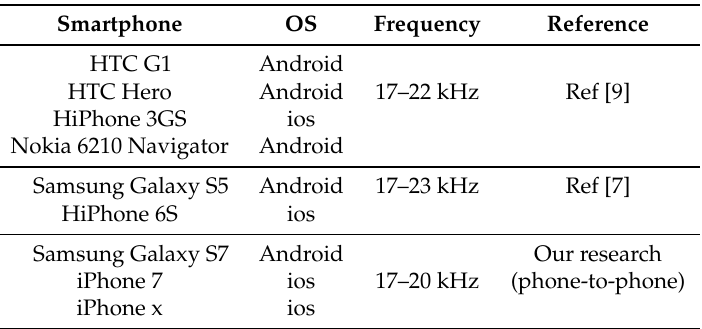
Table 1. Frequency range of acoustic from commercial smartphones.